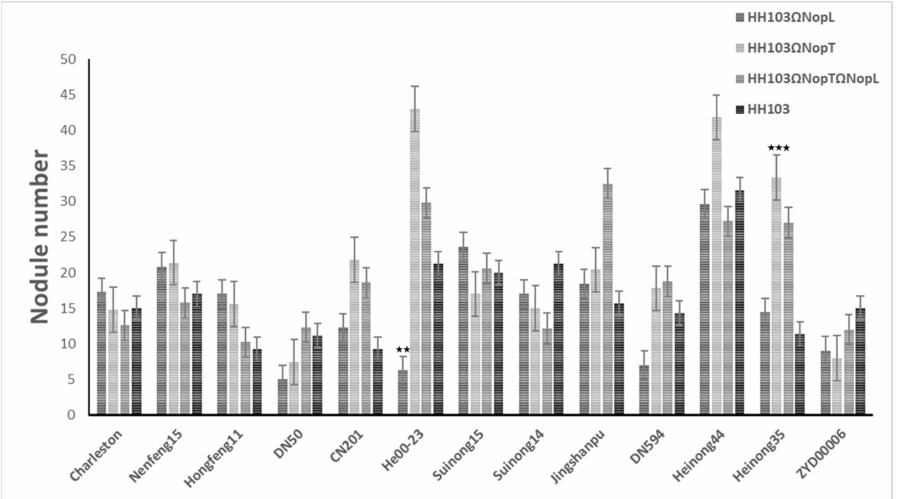
Figure 1. Nodule number phenotype of soybean germplasm after inoculation with S. fredii HH103 and S. fredii HH103 Ω NopL , HH103 Ω NopT and HH103 Ω NopL Ω NopT . Nodulation tests were per- formed three times; t -test was performed comparing the NopP mutant to the wild-type strain; when significant (0.01 ≤ p ≤ 0.05), an asterisk is shown, ** indicates p ≤ 0.01, *** indicates p ≤ 0.001. Ecoregions origin of germplasms: Charleston (America), Nenfeng15 (Heilongjiang), Hongfeng11 (Heilongjiang), Dongnong50 (Heilongjiang), CN201 (Sichuan), He00-23, Suinong15 (Heilongjiang), Suinong14 (Heilongjiang), Jingshanpu (Heilongjiang), Dongnong594 (Heilongjiang), Heinong44 (Heilongjiang), Heinong35 (Heilongjiang), ZYD00006.